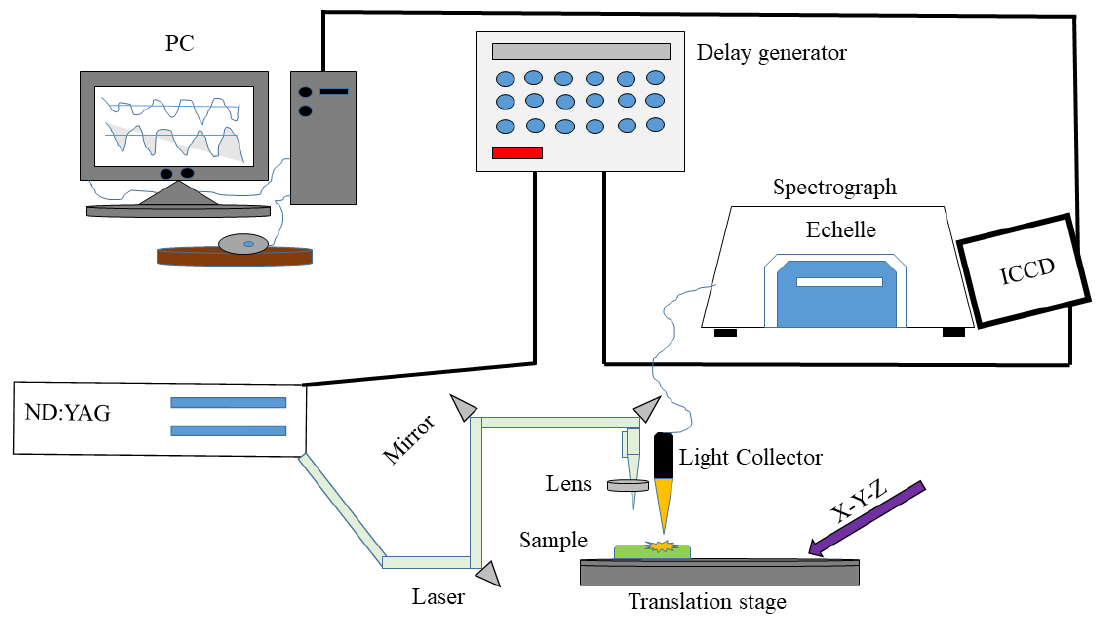
Figure 1. An illustration of the LIBS experimental setup.